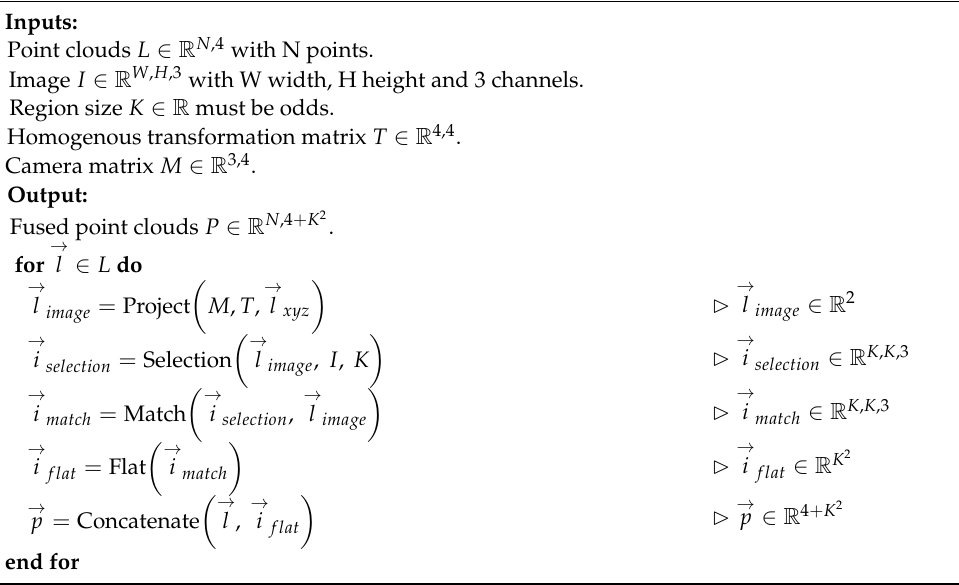
Algorithm 1 Point Cloud-Multiply Pixels Fusion ( L , I , K , T , M